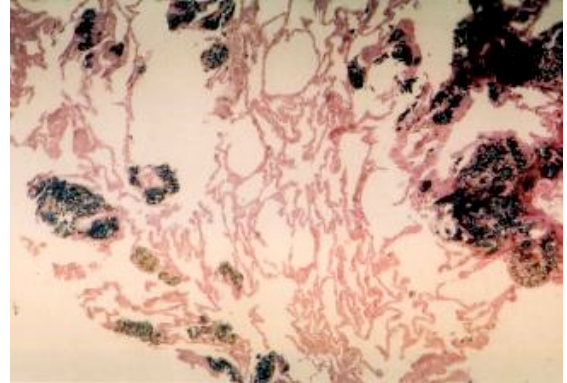
Image 12. Lung of Striped hyena showing granuloma and deposition of carbon particles, Anthracosis, H&E, 100x.